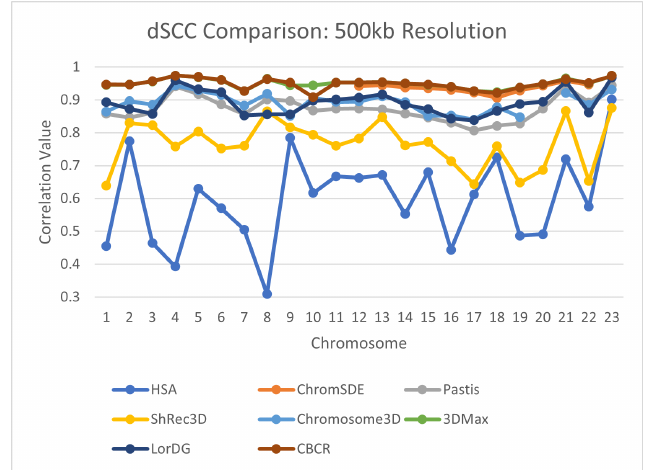
Figure 10. Comparison of dSCC between CBCR and 7 other methods on chromosomes 1–23 at 500 kb resolution.